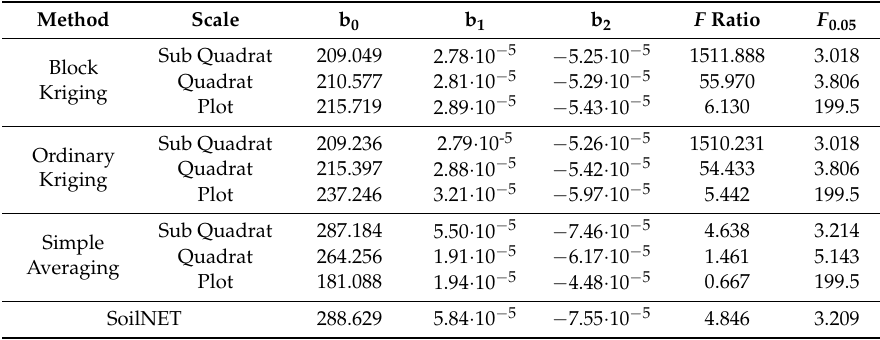
Table 5. The coefficients (b 0 , b 1 , b 2 ) of the binary linear regression equation for the trend surface analysis based on the in situ SoilNET soil moisture observations and the upscaled soil moisture estimations by block kriging, ordinary kriging, and simple averaging, and the F ratio on 30 June. F 0.05 is the F value with the significance level of 0.05.